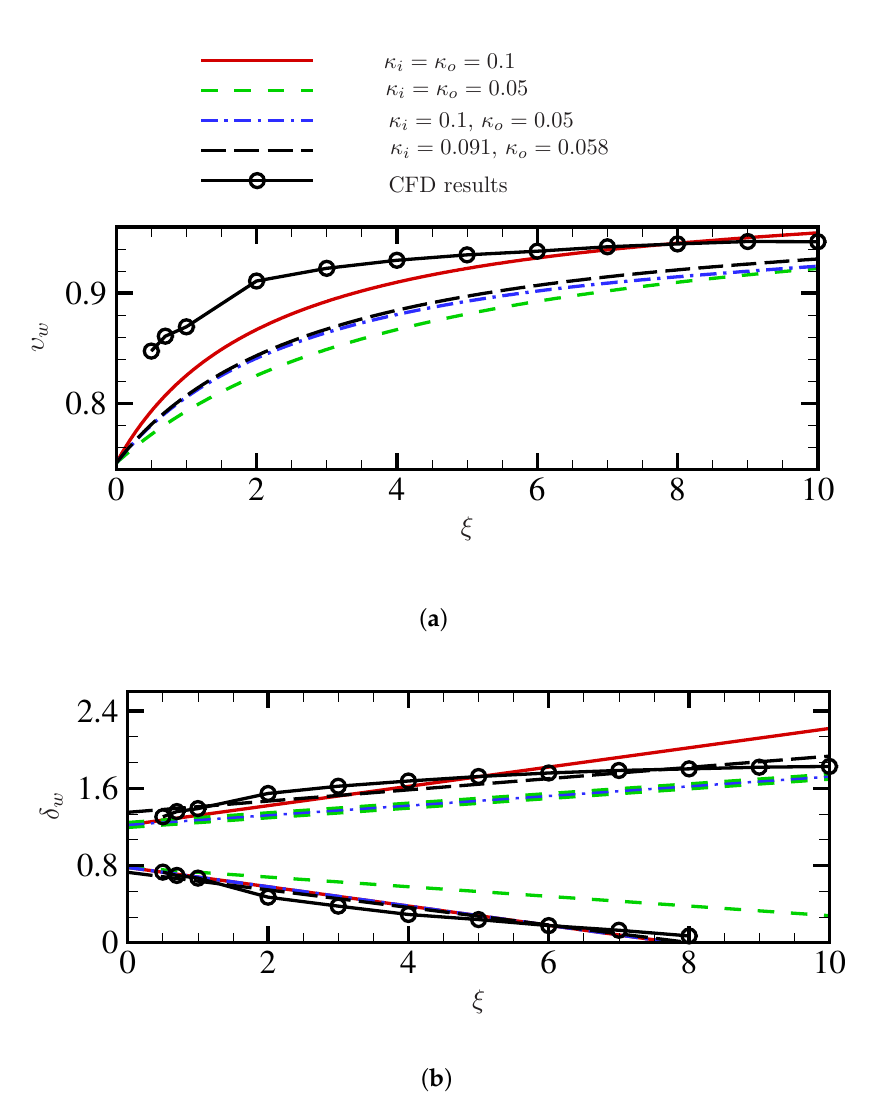
Figure 12. (Colour online) Variation of ( a ) the average dimensionless wake velocity, and ( b ) the dimen- sionless wake radii, as a function of the dimensionless streamwise distance measured from the rotation plane. Results from the analytical wake model: [